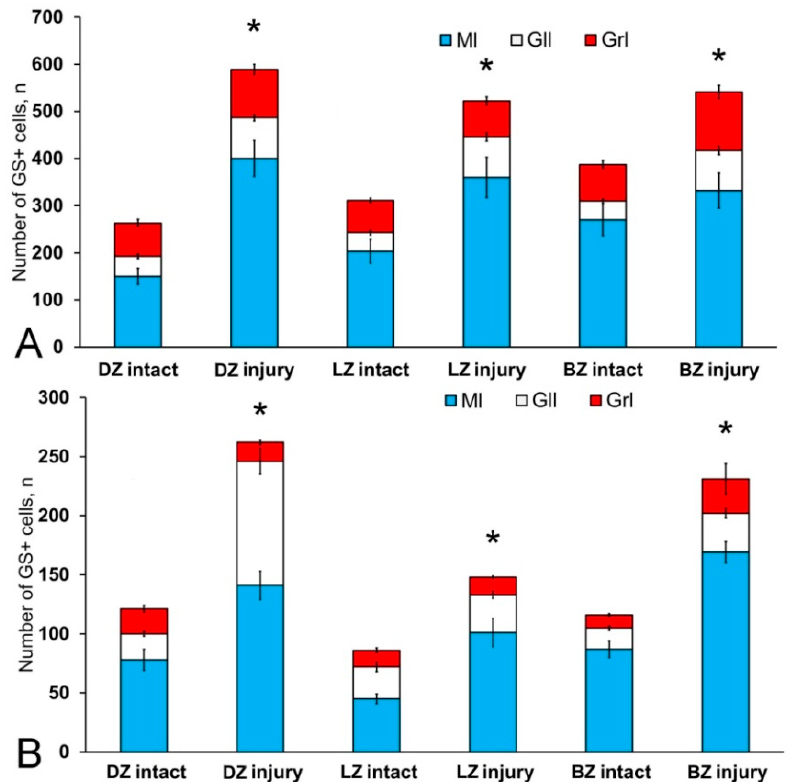
Figure 9. Distribution of GS + cells in the intact cerebellum of juvenile masu salmon, Oncorhynchus masou , and after injury. ( A ) Number of type 1 GS + cells. ( B ) Number of type 2 GS + cells. ( n = 5 in each group; * p ≤ 0.05 is a significant di ff erence vs. control groups). Student–Newman–Keuls test. The X-axis indicates the cerebellar area. DZ, dorsal zone; LZ, lateral zone; BZ, basal zone; Ml, molecular layer; Grl, granular layer; Gll, ganglionic layer.